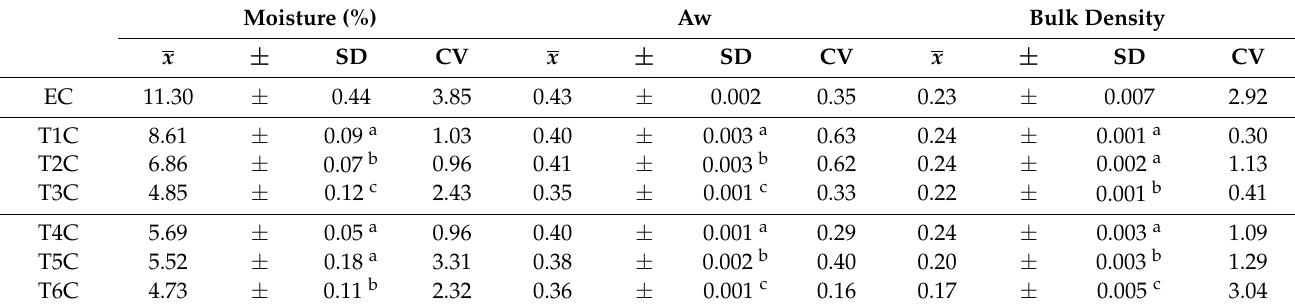
Table 2. Moisture, Aw, and bulk density of erythrocytes and